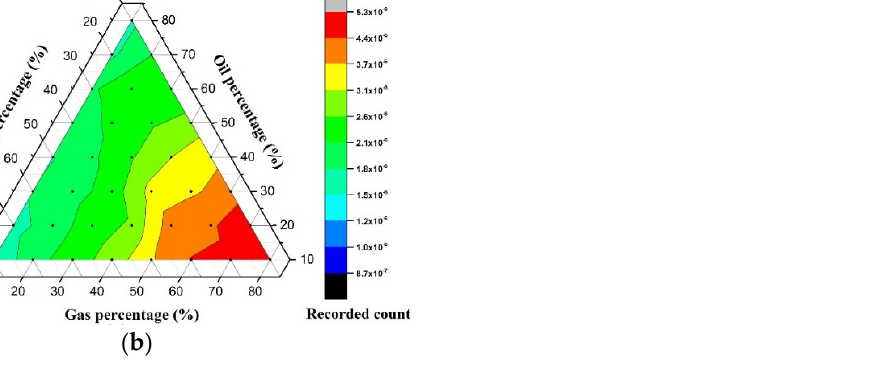
Figure 4. Extracted characteristics in terms of scale thickness in constant volume percentage (10% gas, 40% oil, and 50% water). 3. MLP Neural Network Millions of neurons, or little computer units, make up the human brain. These neu- rons are all linked to one another. Dendrites, which are branching on neurons, are where other neurons send information. The nucleus, which is a neuron’s processing center, con- verts input data into output data that are then sent to other neurons via an output line called an axon. These all take place in the biological and physiological realms. One of the most popular approaches developed by researchers to model this function in mathematics is the MLP neural network. There are input and output layers in this network’s structure. Between these two layers, there may be a variety of hidden layers. A number of mathe- matical operations are carried out in the hidden layers and are introduced as the activation function. The type and level of nonlinearity of the available data determine the structure and number of these layers, and the type of activation function. Numerous studies have used intelligent computing systems to determine various parameters in different fields of